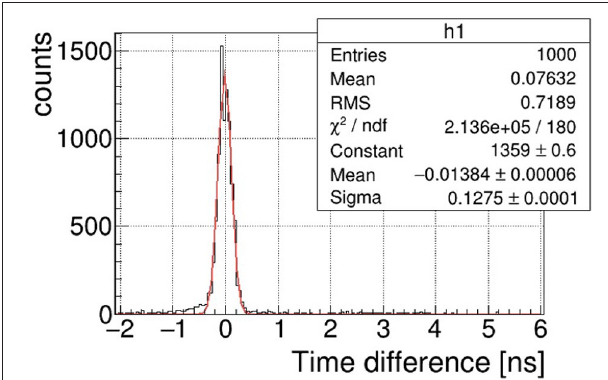
FIGURE 8 | The time precision was estimated testing two identical detectors with a beam of 2.95 GeV protons. Assuming the two detectors have the same precision, σ t 127ps / (2) 91ps (Courtesy of Dr. Jerzy = = p